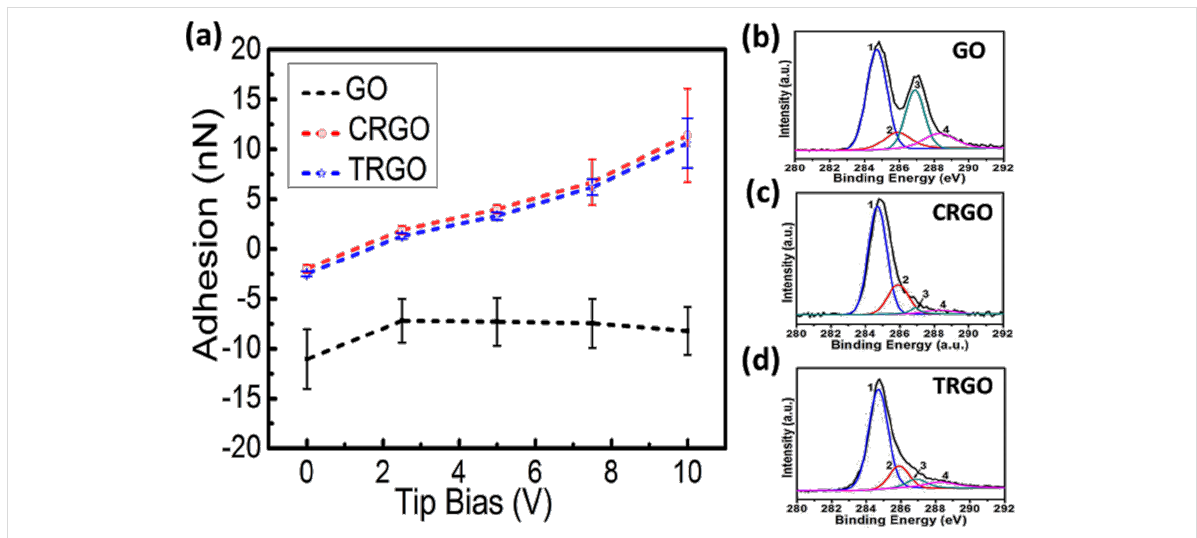
Figure 4: The dependence of the adhesion force on the AFM tip bias for three types of single-layered GO and RGO. (a) The average adhesion forces of the GO, CRGO (chemically reduced by saturated hydrazine vapor at 80 °C for 1 h) and TRGO (thermally reduced at 180 °C for 15 min) plotted against different biases of the AFM tip. XPS spectra of (b) GO, (c) CRGO and (d) TRGO. The peaks 1, 2, 3, and 4 in the coloured curves correspond to C=C/C–C in aromatic rings, C–O (epoxy and alkoxy), C=O, and COOH groups, respectively. The C/O ratios for these samples are 1:1, 3.3:1, and 3.2:1,